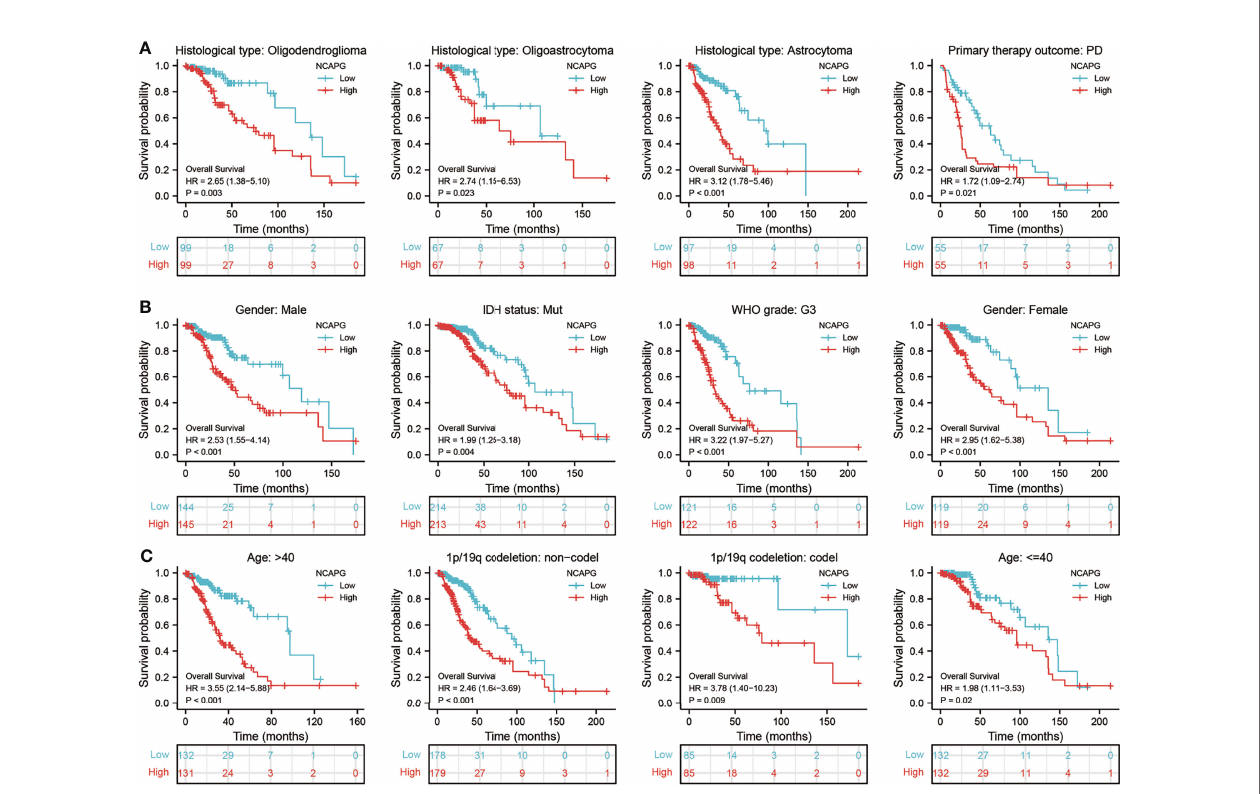
FIGURE 3 | Analysis of the prognostic value of NCAPG in different glioma subgroups. Analysis of the prognostic value of NCAPG in different subgroups, including (A) histology type, (B) sex, IDH mutation status, WHO grade, and (C) age, 1p/19Q